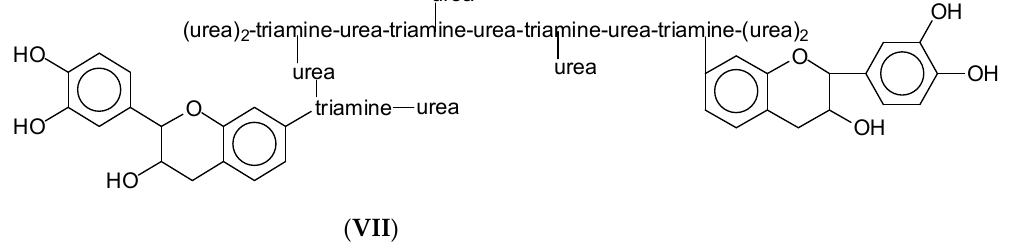
Figure 9. An example of a detected structure with two flavonoid units linked to a triamine-urea hyperbrached network part.